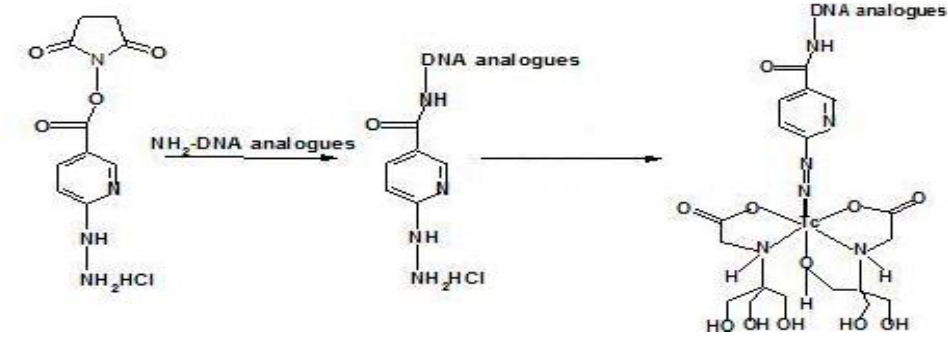
Figure 6. Conjugation of the NHS-Hynic to amine-derivatized oligomers, and radiolabeling with 99m